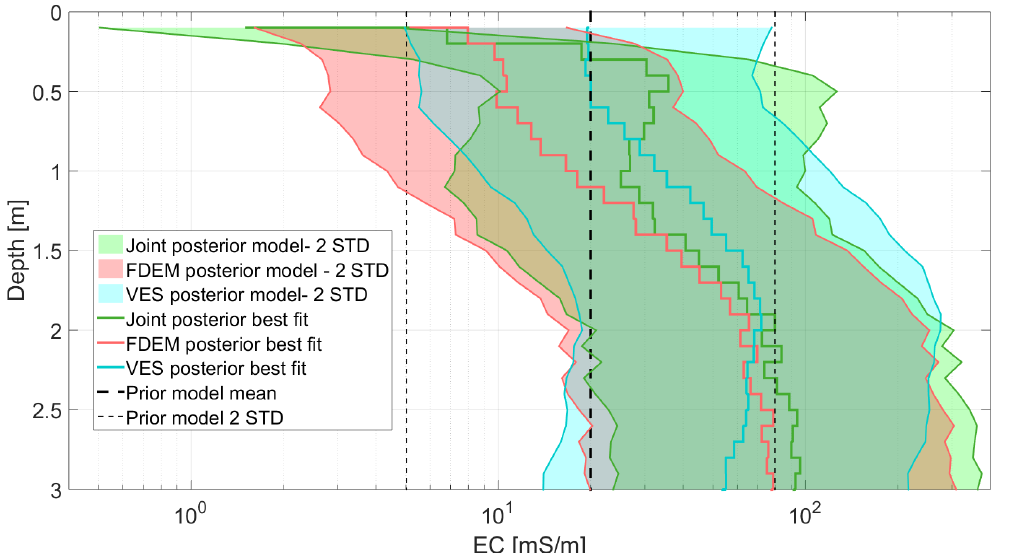
Figure 7. Kalman ensemble generator (KEG) inversion results for the same synthetic true model using the same prior model for vertical electrical sounding (VES) data, frequency domain electromagnetic (FDEM) data, and joint inversion of VES and FDEM